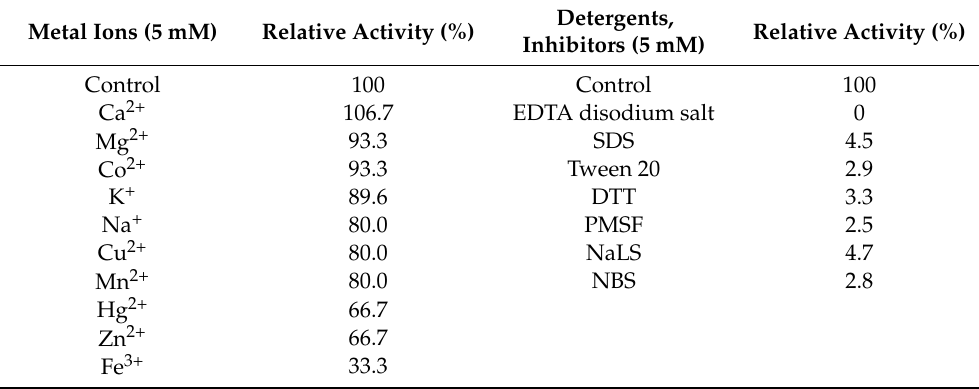
Table 2. Influence of some metal ions and surfactants on the lipase